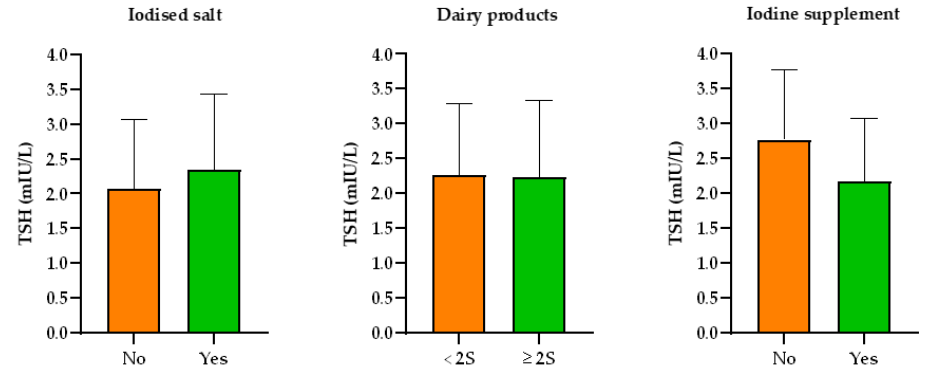
Figure 2. Source of iodine consumption in relation to thyroid function data, the latter is expressed as mean (coloured bars) and SD (whiskers). No statistically significant relationship was found in any scenario. <2S: less than two servings a day; ≥2S: two or more servings a day. Table 3. Iodine consumption data and TSH